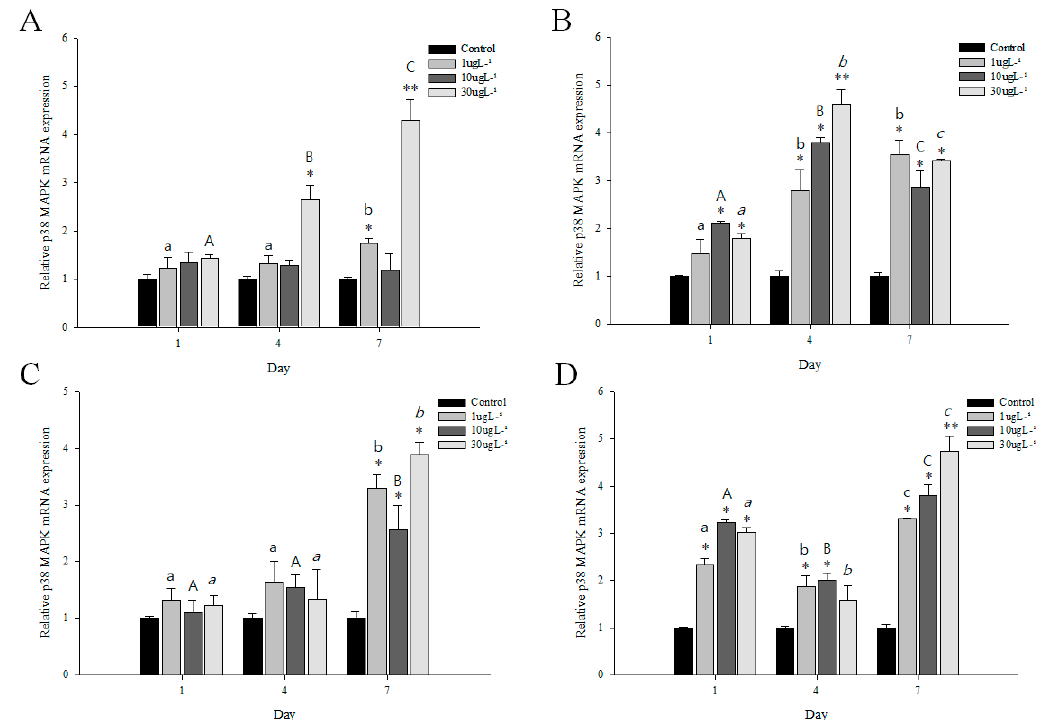
Figure 4. Relative expression of p38 MAPK mRNA in M . japonicus gills ( A , C ) and hepatopancreas ( B , D ) exposed to 1, 10, and 30 µ g L − 1 perfluorooctane sulfonate (PFOS; A , B ) and irgarol ( C , D ) at days 1, 4, and 7. The values were normalized against GAPDH. Values of each bar represent the mean ± SD. A statistically significant difference is presented by an asterisk at * p < 0.05 and ** p < 0.01 compared with the control (relative control value of p38 MAPK = 1).